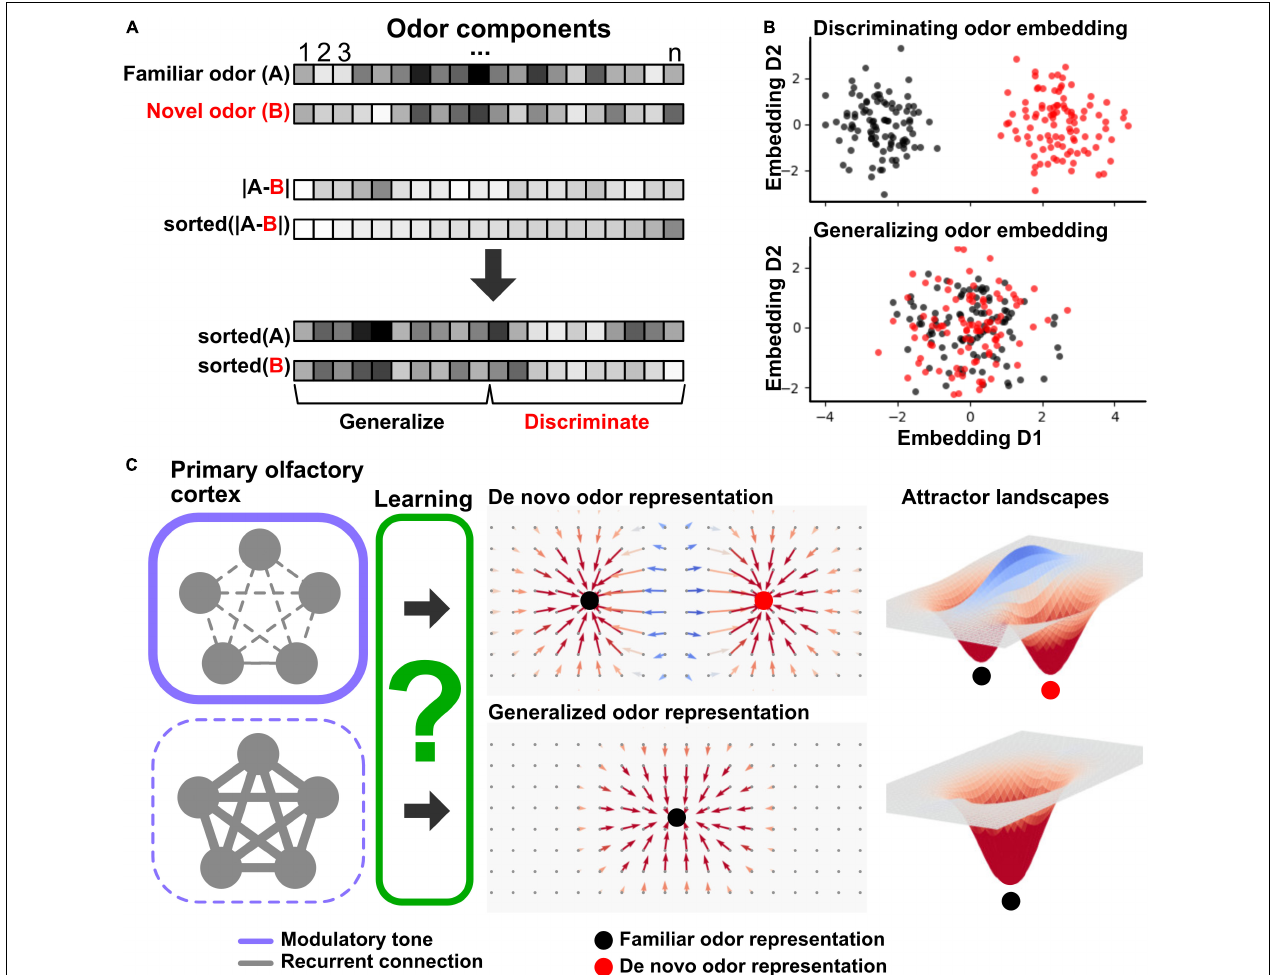
FIGURE 1 | Schematic of categorical learning in primary olfactory cortex. (A) Odor stimuli as high-dimensional feature vectors. (Top) a familiar odor (A) is characterized by a distribution of odor component concentrations (horizontal box row, high concentration indicated by dark coloring). A novel odor (B) is shown below that has considerable overlap with odor A in its component distribution. (Middle) absolute difference in component concentration between odors A and B (top box row) and the same difference but sorted according to value (bottom box row). (Bottom) the original odors A and B component distributions shown in panel (A) but sorted according to component similarity. The left-hand side reflects components that are most similar between the odors, while the right-hand side reflects components that are the most dissimilar, supporting generalization and discrimination respectively. (B) Low dimensional embeddings of odors A and B according to maximum discrimination (top) or generalization (bottom). Each dot represents one exposure to an odor (odors A and B, color-coded by black and red, respectively). The embeddings are computed using the top two (top panel) and bottom two (bottom panel) principal components (D1 and D2) of component distributions across the odors. The embeddings highlight that within overlapping odor distributions, there are embeddings that may dynamically cater to either discrimination (top) or generalization (bottom) depending on component weighting. (C) Schematic of proposed role of modulatory system regulation of generalization-discrimination balance during odor learning through regulation of recurrent primary olfactory cortical connections. (Left) Recurrent connections (gray lines) between neurons (gray circles) represent primary olfactory cortical ensembles. When faced with a novel odor stimulus, modulatory tone (purple frames) regulates activity in recurrent connections which biases learning between generalization and discrimination. High modulatory tone inhibits recurrent activity (top, indicated by thick frame and thin connections), while low modulatory tone boosts recurrent activity (bottom, indicated by thin frame and thick connections). Through learning (green box, unknown mechanisms), the primary olfactory cortex either sets up categorical representations that discriminate a novel odor into a de novo representation separate from a familiar odor (top panel) or generalizes the novel odor into an existing familiar odor representation (bottom). The middle panels schematically illustrate neural phase space diagrams. The 2D surface represents variable neural ensemble activations that then through attractor dynamics converge to an invariant and categorical response (vectors leading to filled circles). The top panel shows the neural phase space resulting from a de novo categorical representation reflected in two fixed point attractors (black and red circles, familiar and de novo representations, respectively), while the bottom panel shows the neural phase space resulting from generalizing a novel odor into a familiar representation as reflected in a single fixed-point attractor (black circle). (Right) attractor dynamical landscapes associated with the neural phase space diagrams in the middle. Filled circles denote attractor